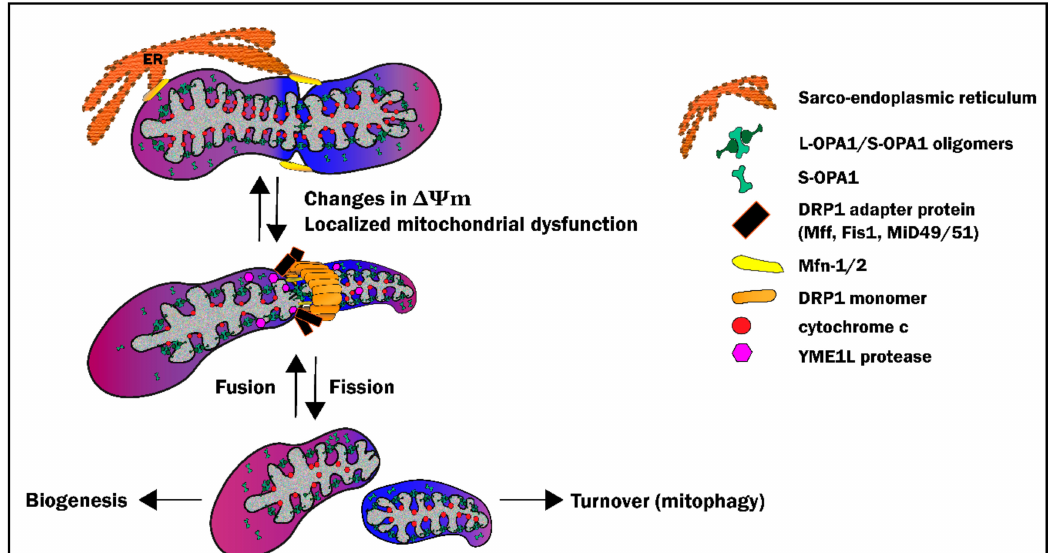
Figure 3. Mitochondrial morphosis under physiologic conditions. The dynamic fission-fusion balance occurs under steady-state conditions to promote mitochondrial biogenesis and / or culling of dysfunctionalmitochondriabymitophagy. DRP1-mediatedfissionattheoutermitochondrialmembrane reportedly occurs through interaction with cognate adapter proteins (M ff , Fis1, MiD49 / 51) at specific ER-contactfoci. TransientcyclingofDRP1tothesefociissuggestedtomaintainthefission-fusionbalance. Dysfunctional mitochondrial segments are represented in blue, viable mitochondria represented in purple. OPA1 = opticatrophyprotein-1; DRP1 = Dynaminrelatedprotein-1; Mfn 1 / 2 = mitofusins 1 &